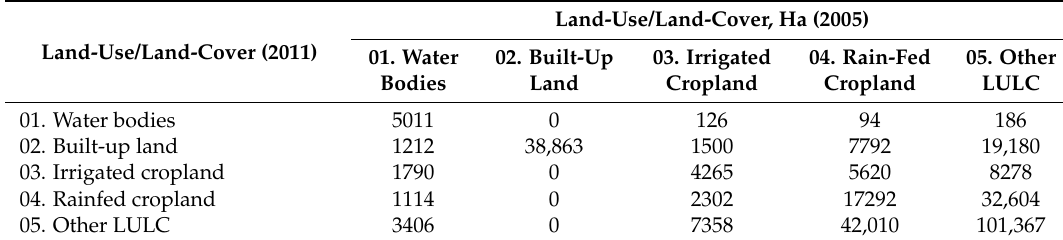
Table 6. Matrix of Land-use/land-cover (LULC) changes from 2005 to 2011.